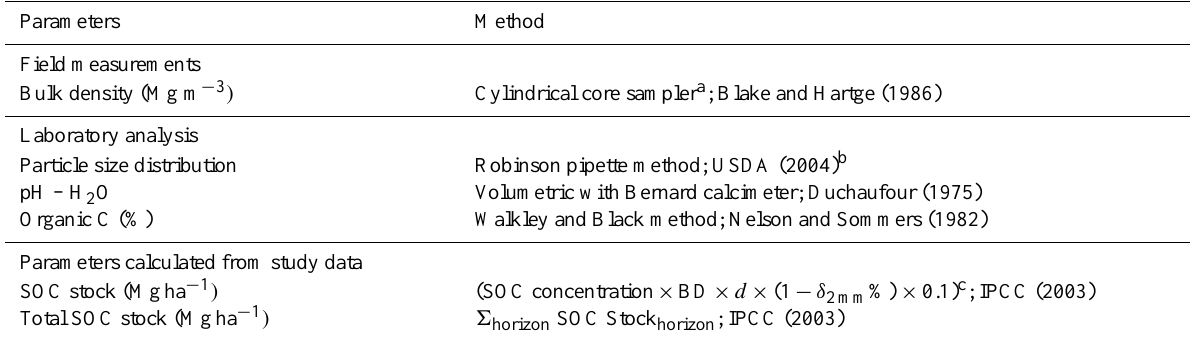
Table 2. Methods used in field measurements, laboratory analysis and to make calculations from study data.